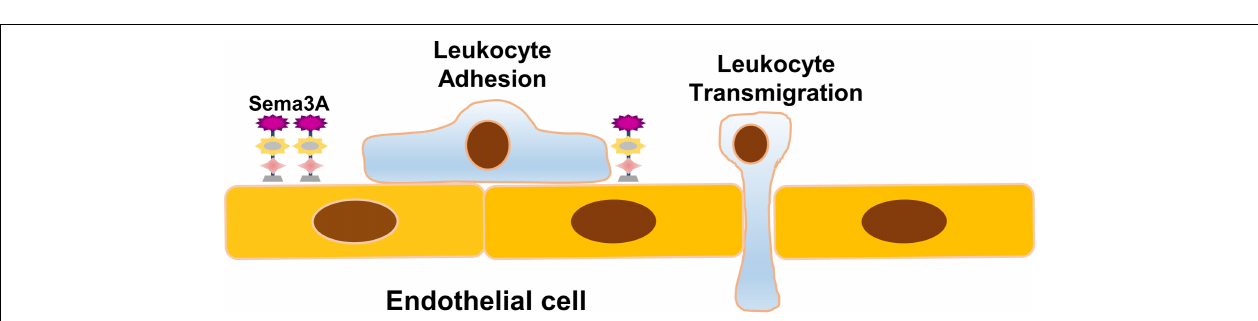
FIGURE 1 | Schematic representation of semaphorins and semaphorin receptors. The semaphorin family can be divided into eight classes. Classes 1 and 2 are found in invertebrates and classes 3–7 belong to vertebrates. Classes 2 and 3, and the viral semaphorin 8 are secreted whereas classes 4–6 are transmembrane proteins. Class 7 is the only GPI-anchored protein. Each semaphorin consists of a large sema domain, a plexin-sema-integrin domain (PSI), immunoglobulin (Ig)-like domains, and thrombospondin repeats. Semaphorins signal through their receptors, plexins. Plexins A and B are found in invertebrates. Vertebrates have plexins A1–4, plexins B1–3, PlexinC1, and PlexinD1. Plexins contain a sema domain, a PSI domain, and an Ig-like, plexins, transcription factors (IPT) domain. Structurally, the cytoplasmic domain of the plexin contains two GTPase activating protein (GAP) domains, including one GTPase-binding domain and one PDZ domain (postsynaptic protein PSD-95/SAP90, the Drosophila septate junction protein Discs-large, and the tight junction protein ZO-1 domain) (B-type plexins only). In invertebrates, semaphorins 1 and 2 signal through Plexin A and Plexin B. In vertebrates, semaphorins 3, 5, and 6 signal via Plexin A, while semaphorin 3 requires a combination of neuropilins (Nrp1 or Nrp2) for signal transduction. Neuropilin is a transmembrane receptor composed of two complement-like (CUB) domains, two FV/FVIII clotting factor-like domains, one meprin-like MAM domain, and a short cytoplasmic tail.